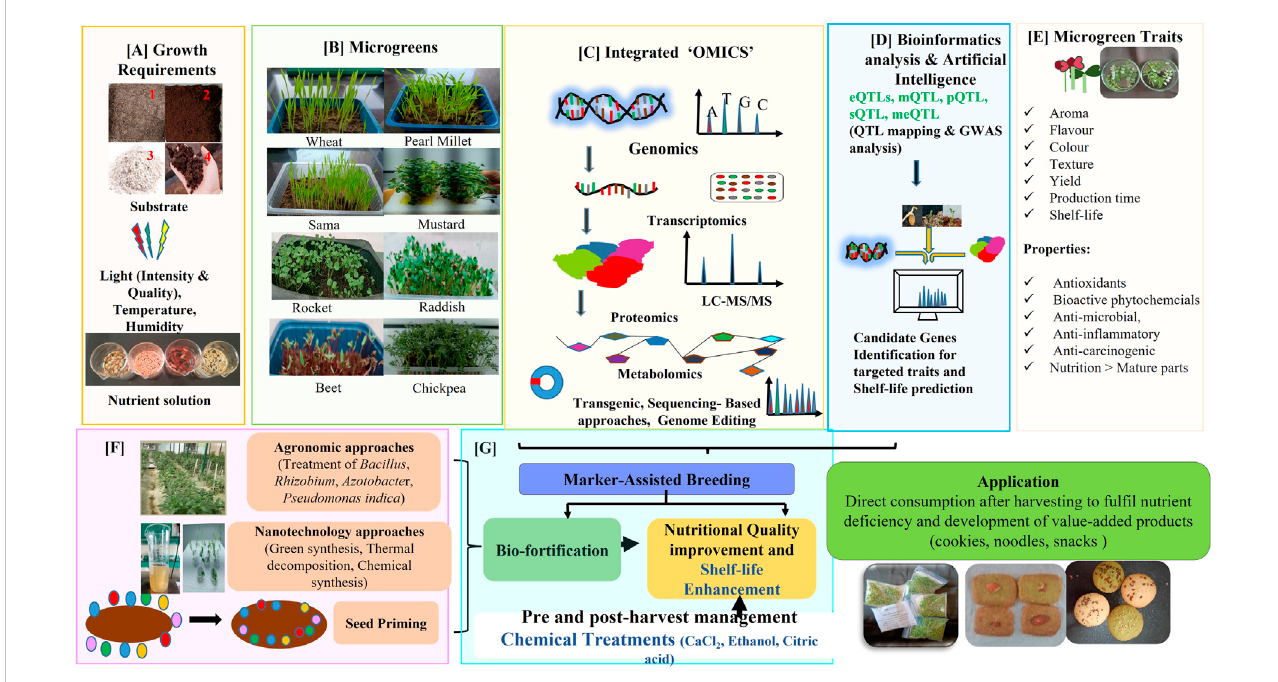
FIGURE 2 Summarizes prospects of microgreens as budding live functional food. (A) Growth conditions required for microgreens cultivation which includes a varietyofsubstrateslikevermiculite(1),cocopeat(2),perlite(3)andvermicompost(4),light(quality,intensityandduration),temperature,humidityandnutrient solution. (B) Microgreens of different plant species: Wheat, Pearl millet, Sama, Mustard, Rocket, Raddish, Beet and Chickpea. (C) Numerous “ OMICS ’ approaches such as Genomics, Transcriptomics, Proteomics, Metabolomics, Epigenomics, along with Transgenics, Gene editing and Sequencing based approachescanbeintegratedwithbioinformatics toolsandarti fi cialintelligence (D) totagQuantitativeTraitLoci(eQTLs:mRNAexpressionQuantitativeTrait Loci; meQTLs: Methylation Quantitative Trait Loci; PQTL: Protein Quantitative Trait Loci; sQTL: splicing Quantitative Trait Loci; mQTLs: Metabolic QuantitativeTrait Loci) and candidate genes identi fi cation for microgreen related desirable traits (E) likenutrients, fl avour, colour, early germination,yield and shelf life. The data generated from Integrated “ OMICS ’ approaches can be further utilized in molecular breeding to produce nutritionally rich varieties